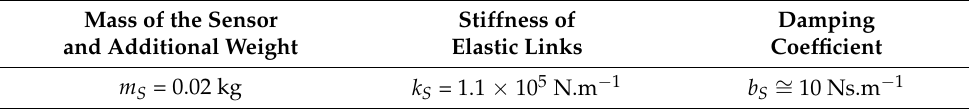
Table 4. Mass properties and parameters of elastic and damping links.